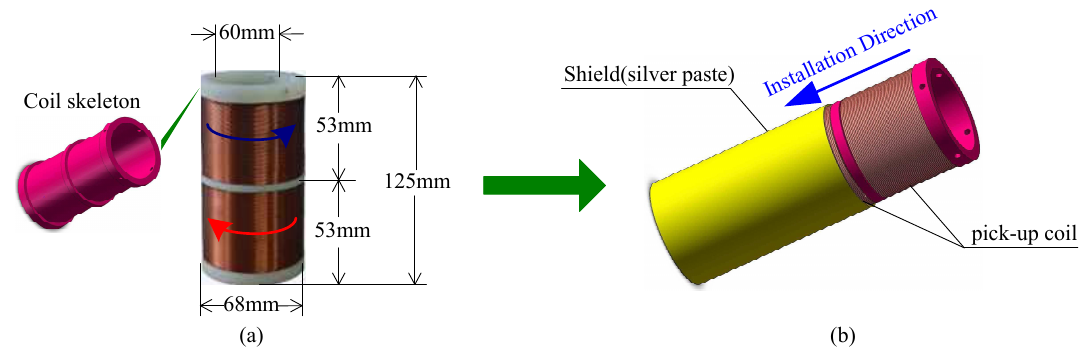
Figure 6. Photograph of the receiving coil. ( a ) Two series-opposing coils; ( b ) the installation of the coils and